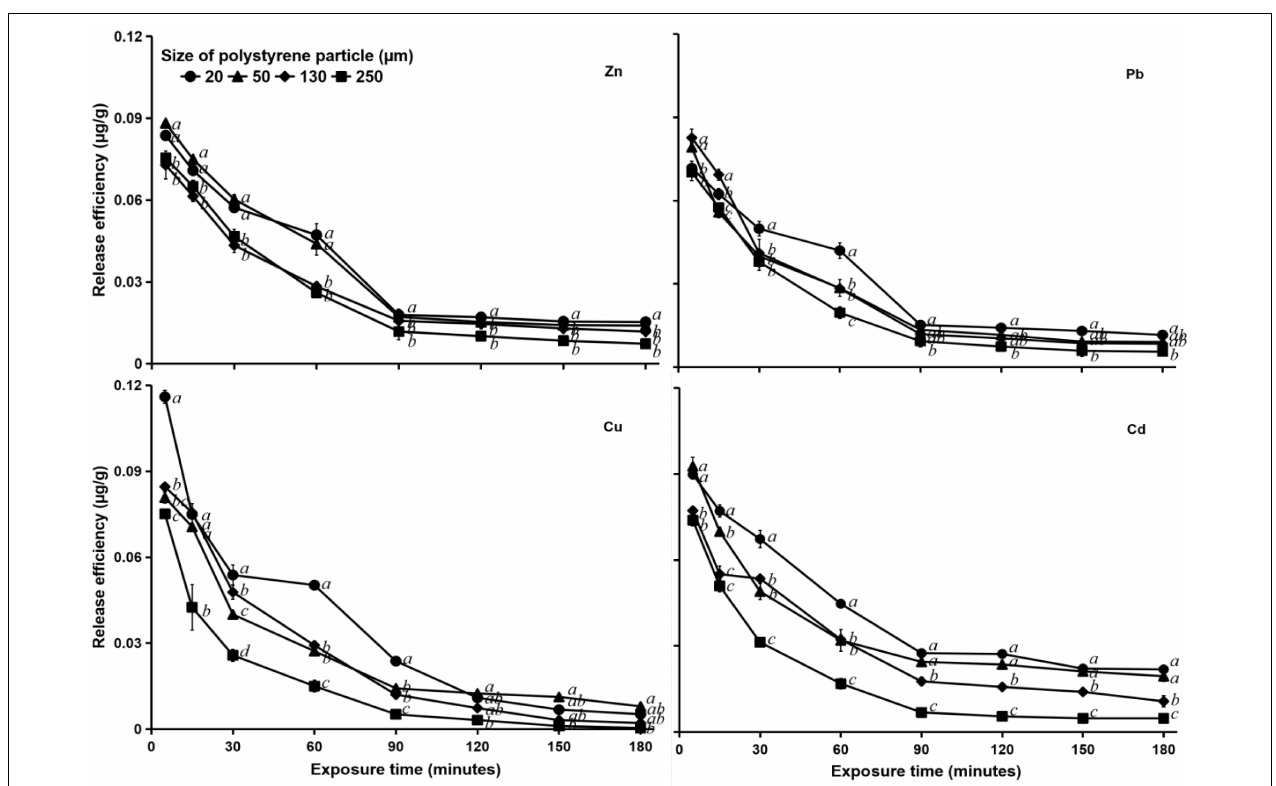
FIGURE 5 | Heavy metal (Zn, Pb, Cu, and Cd) release efficiency ( µ g g − 1 ) in MPs of different sizes (20, 50, 130, and 250 µ m) in water with a salinity of